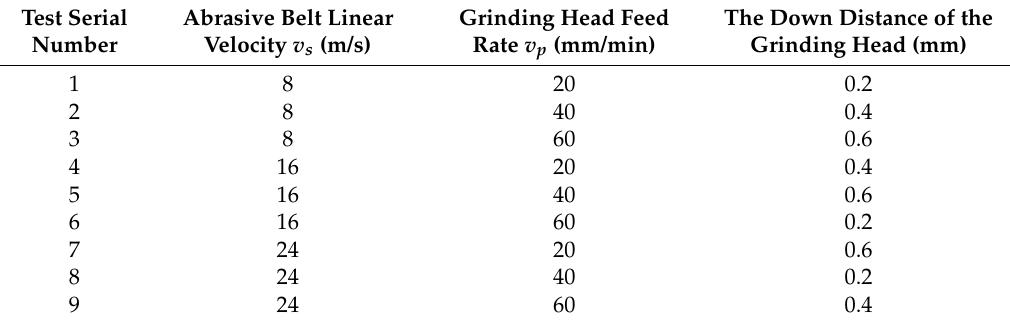
Table 5. Specific parameters of each group of